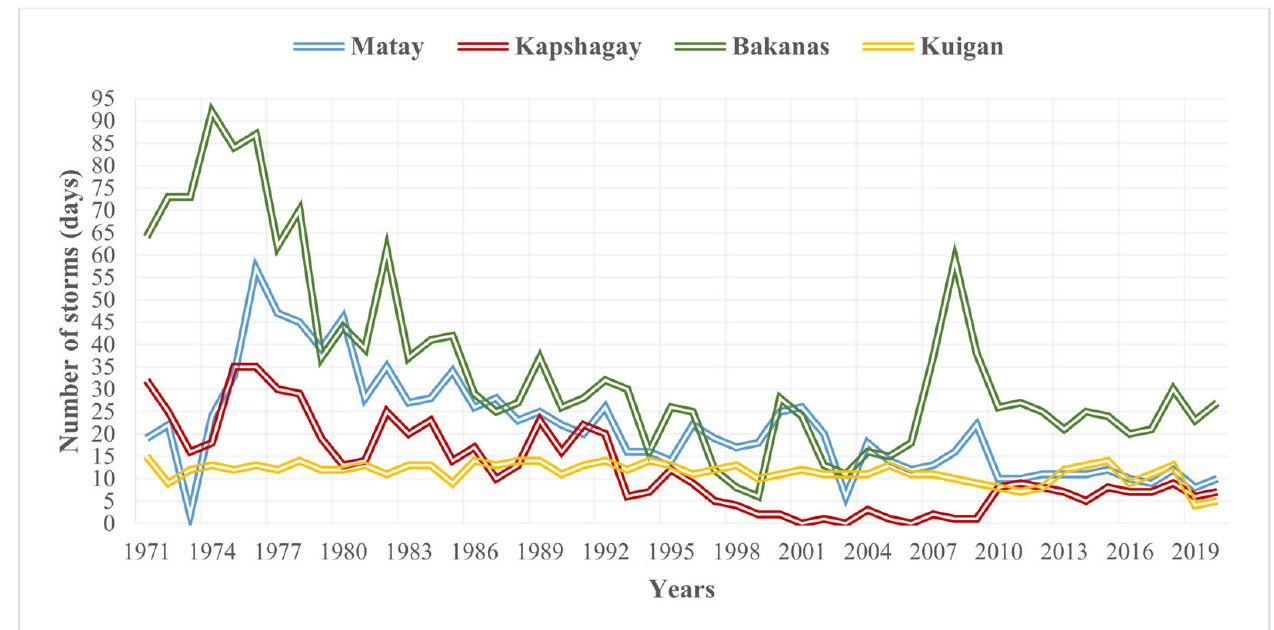
Figure 3. Long-term dynamics of sand and dust storms in the Southern Balkash Figure 3. Long ‐ term dynamics of sand and dust storms in the Southern Balkash deserts.